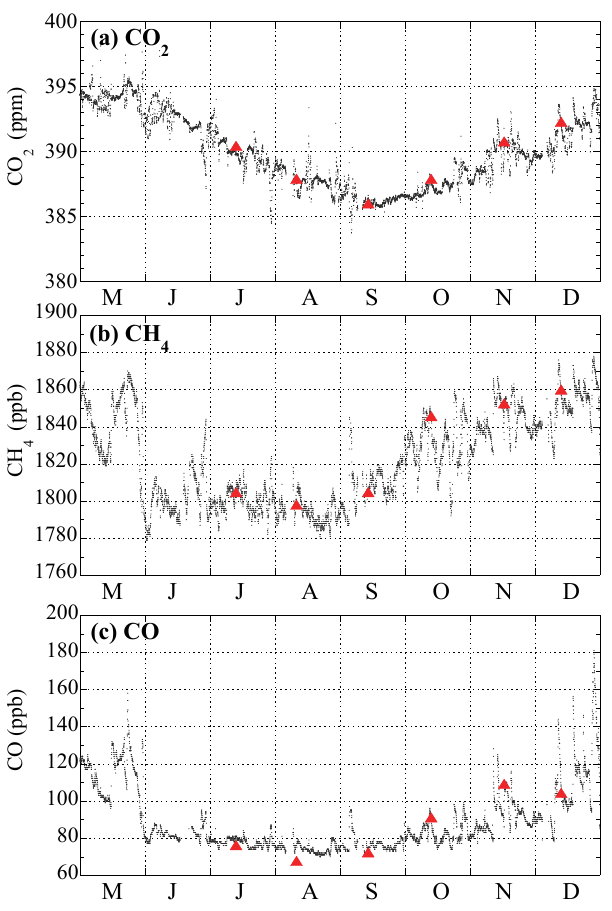
Fig. 2. Temporal variations of CO 2 (a) , CH 4 (b) , and CO (c) mole fractions over Minamitorishima during May–December in 2010. The red closed triangles and the solid dots represent aircraft measurements at 1000ft (average of 4 flask samples) and hourly- averaged data from the ground-based station,